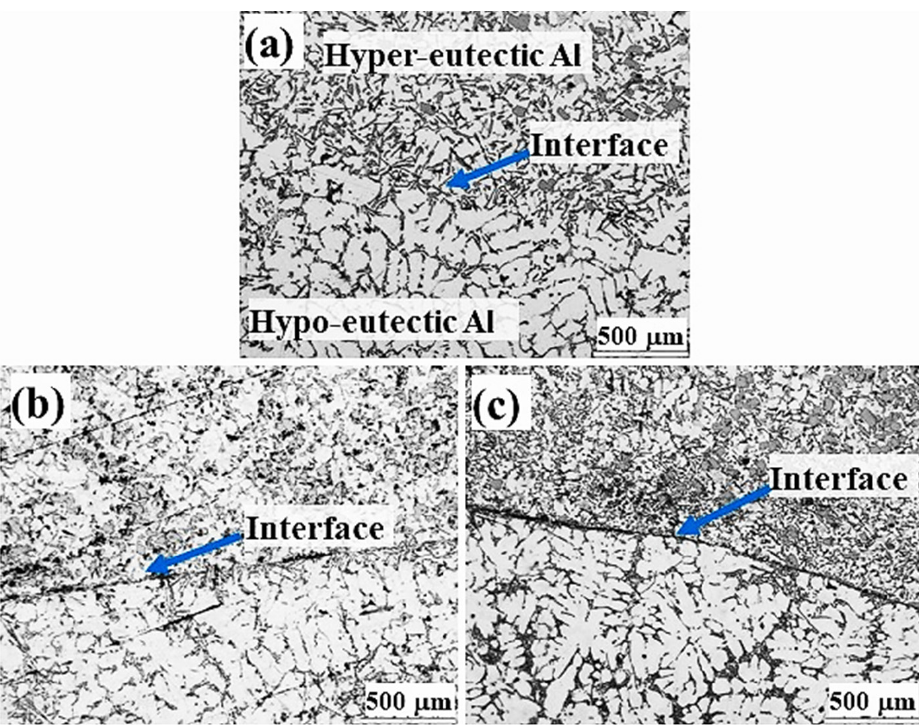
Figure 4. Microstructure of Al/Al bimetal casting in metallic mould casting for three different time intervals: ( a ) 10 s, ( b ) 20 S, and ( c ) 30 s.